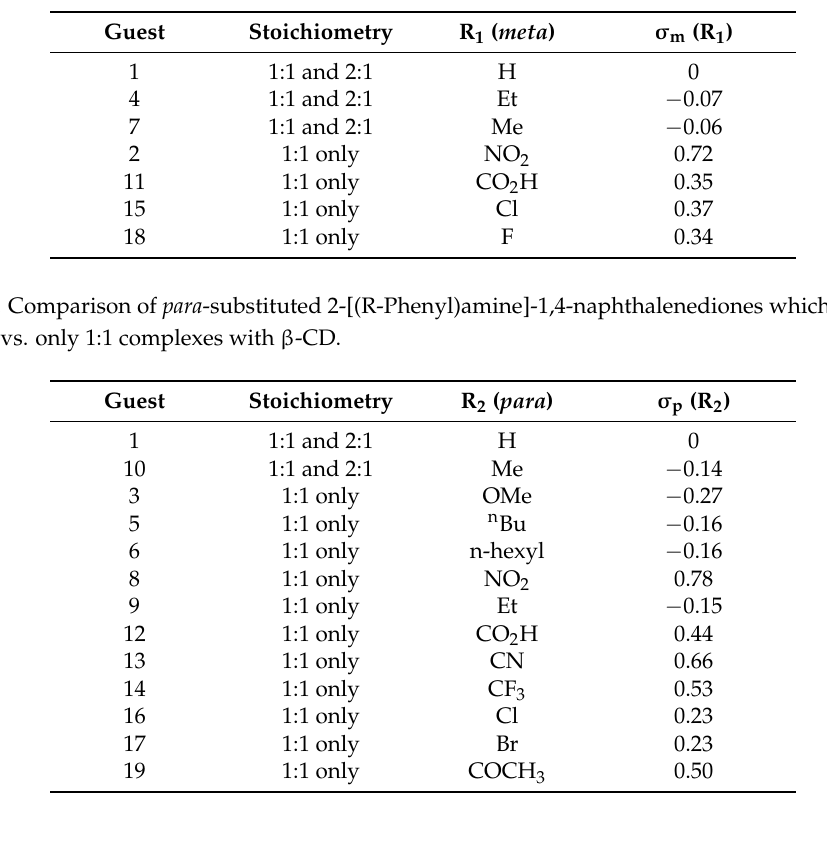
Table 3. Comparison of meta -substituted 2-[(R-Phenyl)amine]-1,4-naphthalenediones which form 2:1